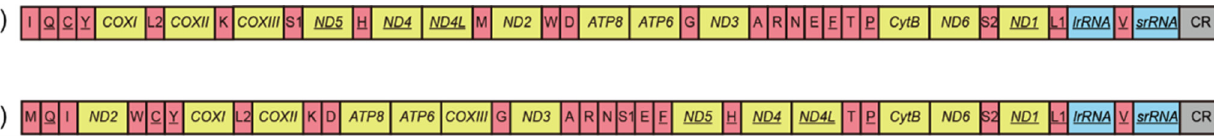
Figure 4. The mitochondrial gene order of the genera Potamyia and Arctopsyche . Genes are tran- scribed from left to right except those underlined, which have the opposite transcriptional orienta- tion. Protein-coding genes are indicated in yellow, tRNA in red, rRNA genes in blue, and control regions in gray: ( a ) Potamyia chinensis and Potamyia horvati ; ( b ) Arctopsyche spinescens and Arctopsyche sp.